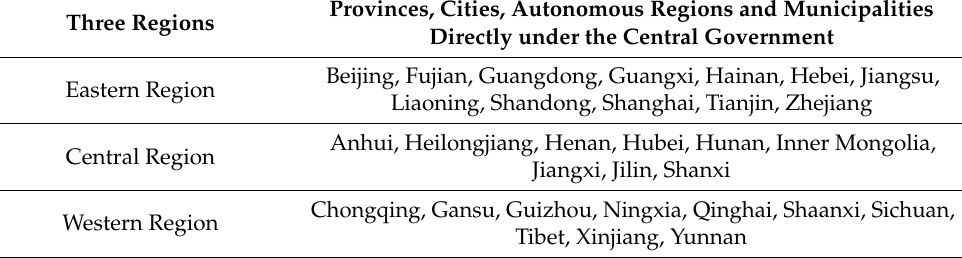
Table 2. Regional division in China. Three